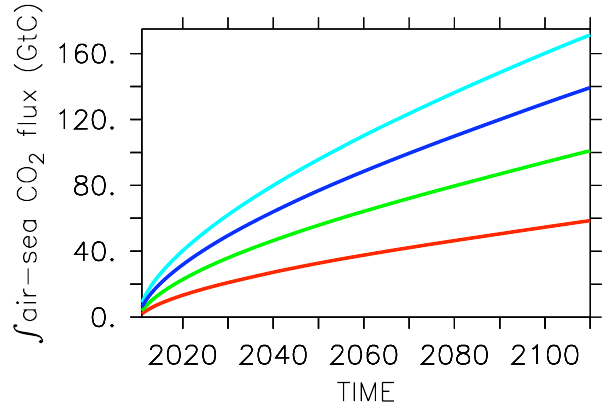
Fig. A2. Cumulative temporal integral of the net oceanic carbon uptake in response to simulated iron fertilization south of 30 ◦ S for the standard OIF experiment of the main text (red) and for the sensi- tivity experiments: OIF simulated by enhancing the phytoplankton maximum growth rate from 0.13day − 1 to 0.39day − 1 (green), to